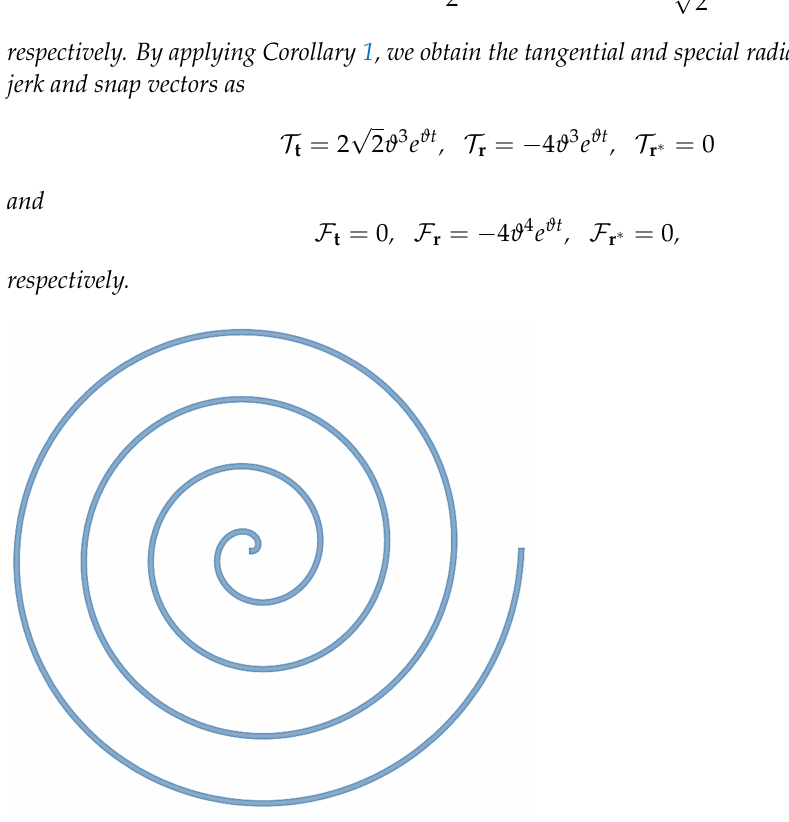
Figure 4. The log-spiral